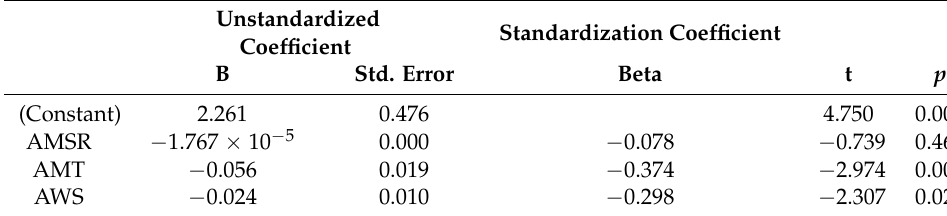
Table 4. Fit parameters for roof length regression model. Unstandardized Standardization Coefficient Coefficient B Std. Error Beta t